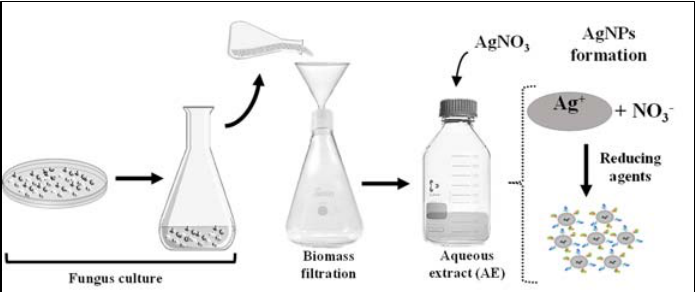
Figure 1. Representation of the silver nanoparticles biosynthesis by the reaction of the extracellular cell free aqueous extract (AE) obtained from the fungi culture with AgNO 3 .